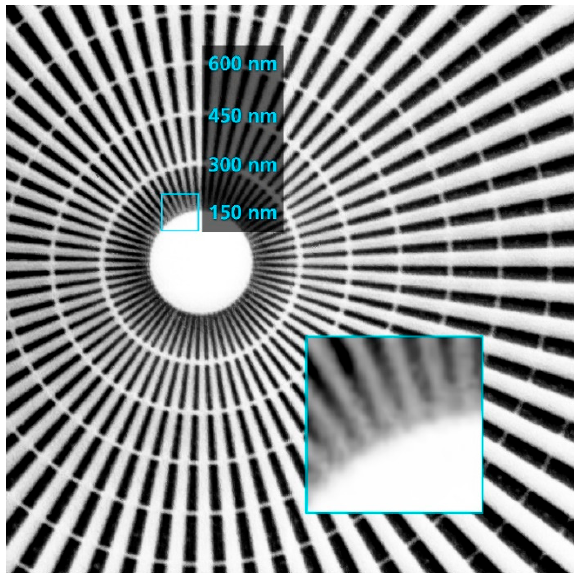
Figure 3. Siemens star test pattern with 300 s exposure time. Inner structure with 150 nm lines and spaces are clearly visible.